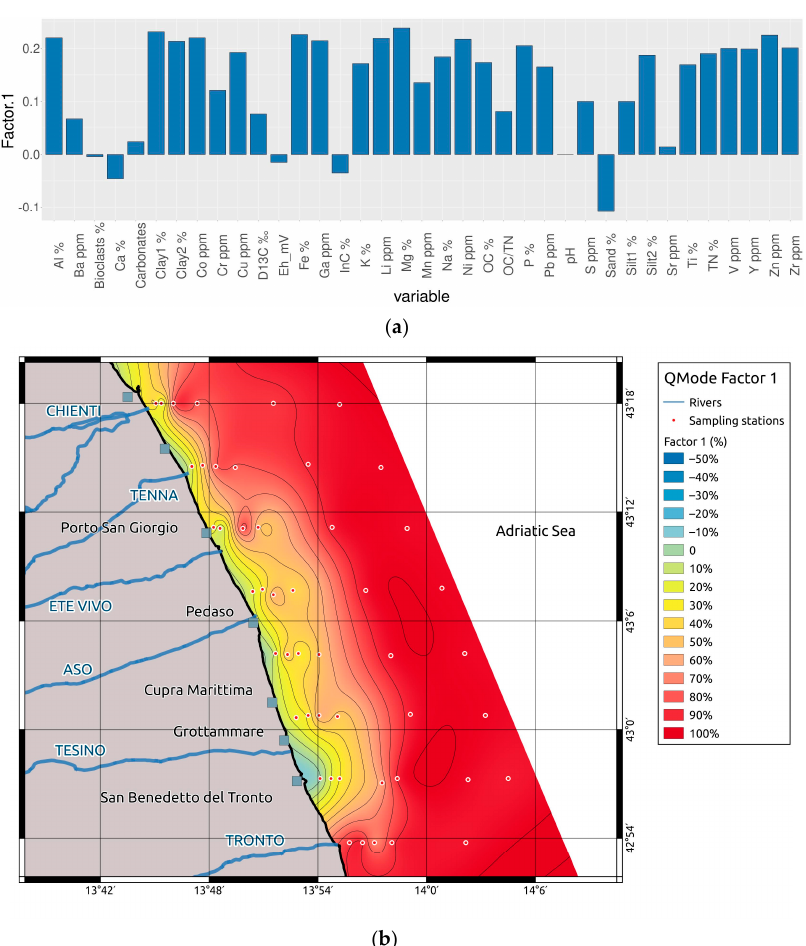
Figure 3. Histogram of the factor scores ( a ) and map of the areal distribution of the of the BSF1 ( b ). The second facies (BSF2) represents 14.5% of the total variance and is marked by high contents of sand, IC, Ca, Sr, OC/TN, pH, and Eh (Figure 4a). Calcium and IC are typical of sediments with abundant carbonate, while high values of pH and Eh are associated to coarse grain-sizes. Based on these characteristics, it can be inferred that the BSF2 is mainly made up of a coarse sandy sediment enriched in carbonates. The areal distribution pattern of the BSF2 (Figure 4b) is complementary to that of the BSF1, with values that suddenly increase the near the coast, where they show values close to 1, meaning sediments con- sisting almost exclusively of carbonate sandy materials and decrease offshore where they reach value lower than 0.1. The origin of the BSF2 sediments is ascribed to the coarse sandy contributions of the local rivers of the Marche Region. They drain the carbonate rocks of the central Apennine and discharge their coarse sediments near the coast, while finer sediments are removed by wave action. The BSF2 facies can be named as Coastal Facies being mainly affected by coastal processes and inputs. The BSF2 presents a smaller extension towards the offshore in front of the Chienti and Tenna rivers and, to a greater extent, in front of the Tronto River where, there is also an area marked by the lowest val- ues. This trend in the areal distribution of BSF2 confirms the greater inputs of fine material from the Chienti, Tenna and, to a greater extent, from the Tronto rivers.